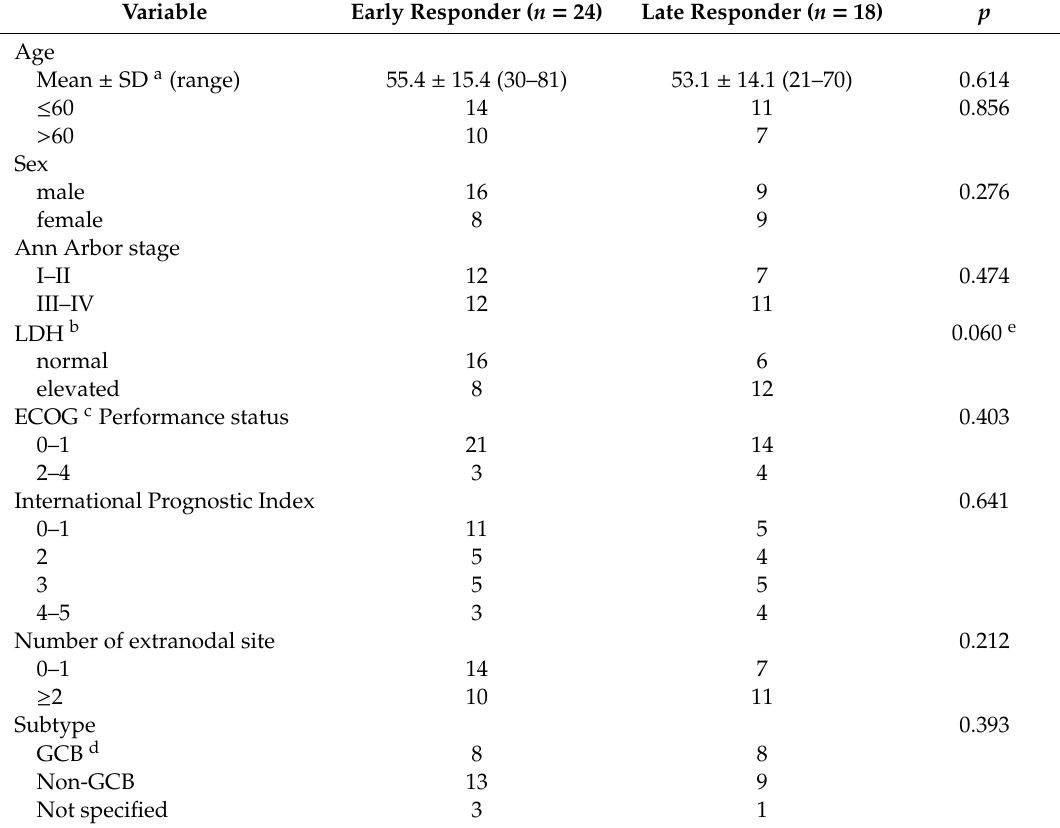
Table 2. Di ff erences between early responders and late responders by D5PS.